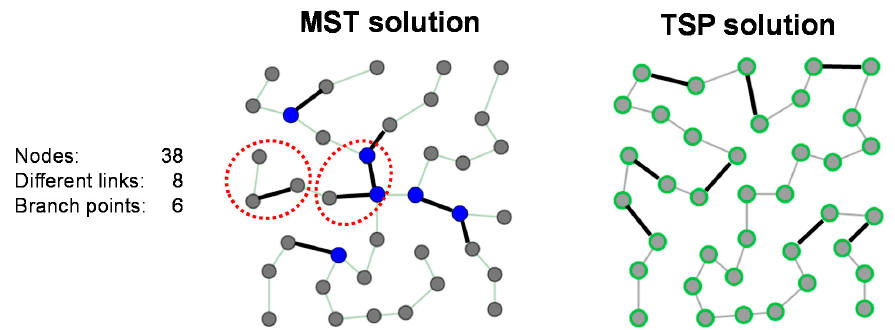
Figure 1. Minimum spanning tree (MST) (left) and open loop travelling salesman problem (TSP) solutions (right) for the same problem instance. The branching nodes are shown by blue, and the links that are different in the two solutions have thicker black line. In addition to the branches, there are only two other places (red circles) where the two solutions differ. Among all links, 29/37 = 78% are the same in both solutions.